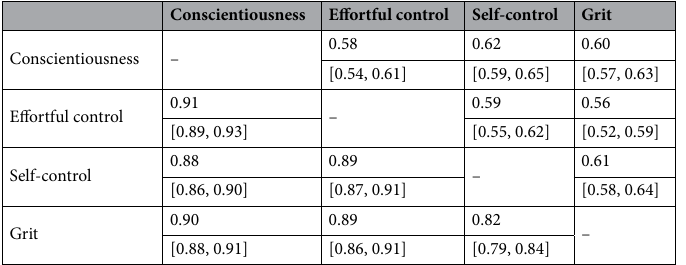
Table 3. Genetic and non-shared environmental correlations among conscientiousness measures (with 95% confidence intervals). Numbers below the diagonal indicate genetic correlations, and those above the diagonal non-shared environmental